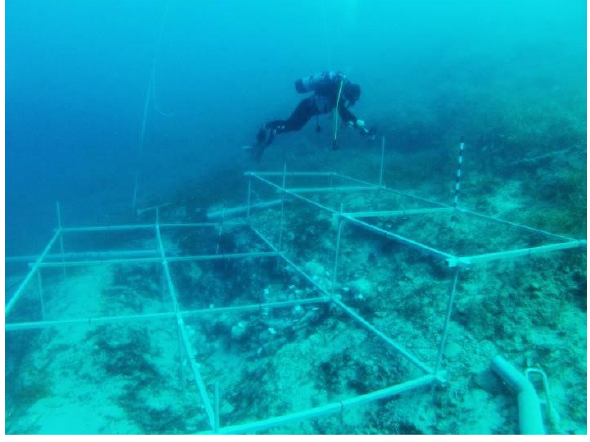
Figure 1. The archaeological site at the end of the excavation in 2012 (photo: D. Della